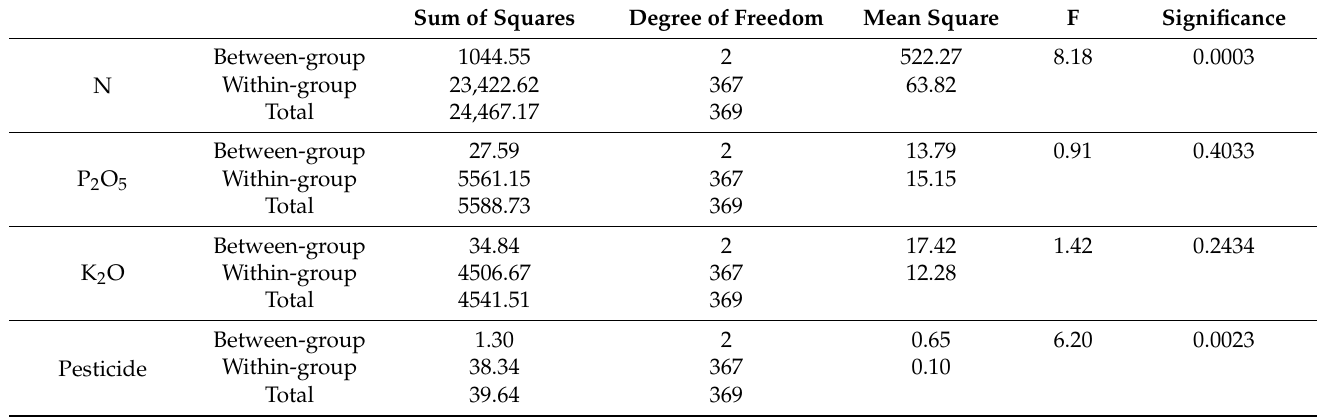
Table 7. Results of the ANOVA analysis.